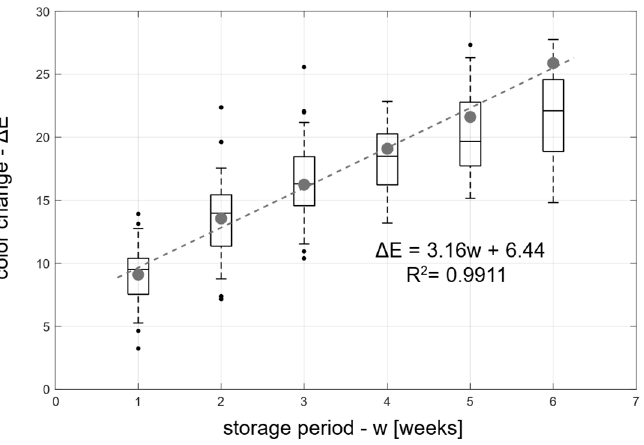
Figure 6. Apple color changes ( ∆ E) during storage at an ambient temperature: the yellow color parameter increases to a specific limit.